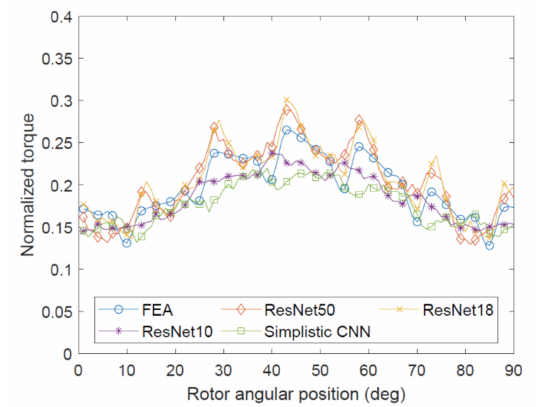
Figure 5. Example of CNN outputs in low-torque region. All architectures show similar accuracy.